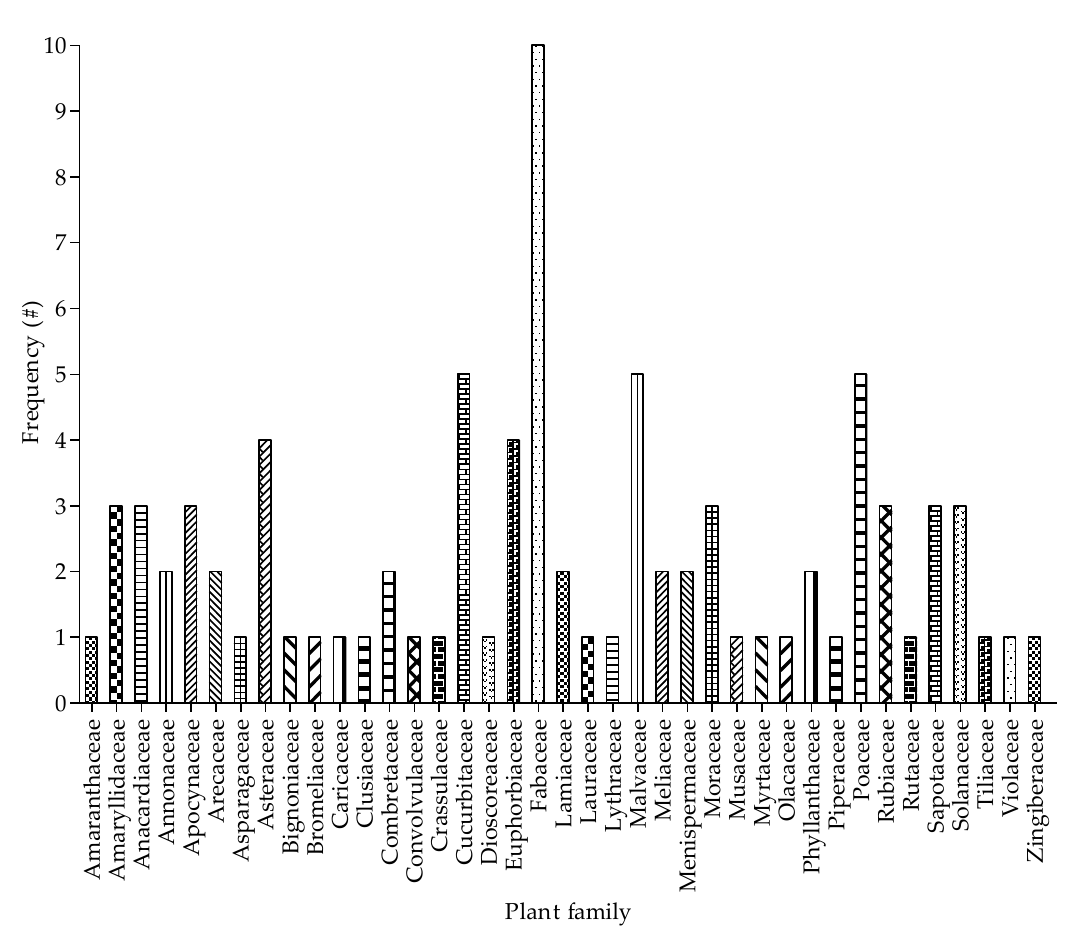
Figure 2. Frequency of plant family used for managing cough associated with respiratory diseases in Ede South Local Government Area of Osun State, Nigeria.